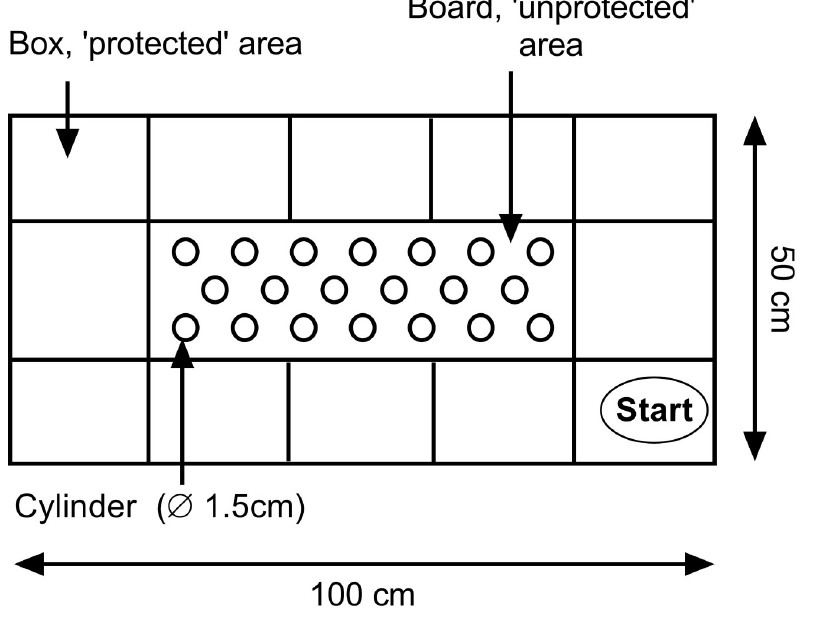
Fig 1. Schematic overview of the modified Hole